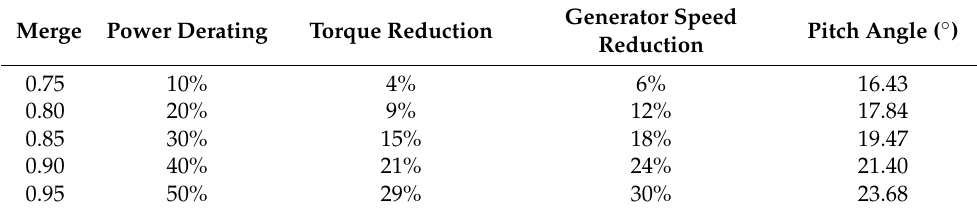
Table 3. Ensemble input and FTC simulation output.